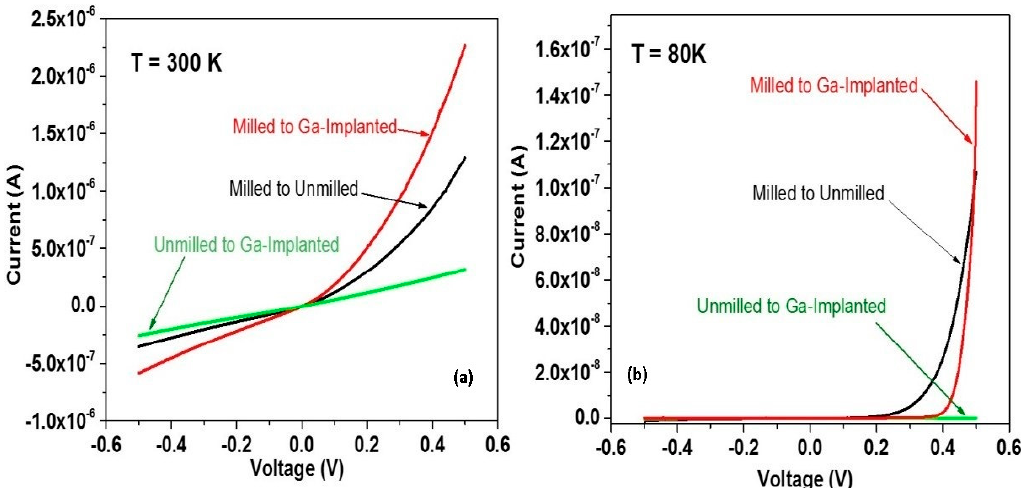
Figure 11. I–V characteristics for pairs of ZnO contacts at ( a ) 300 K and ( b ) 80 K. For both temperatures, the milled contact exhibits Schottky rectification versus ohmic conduction of the unmilled contact. With permission from [18]. Copyright 2018 American Chemical Society.